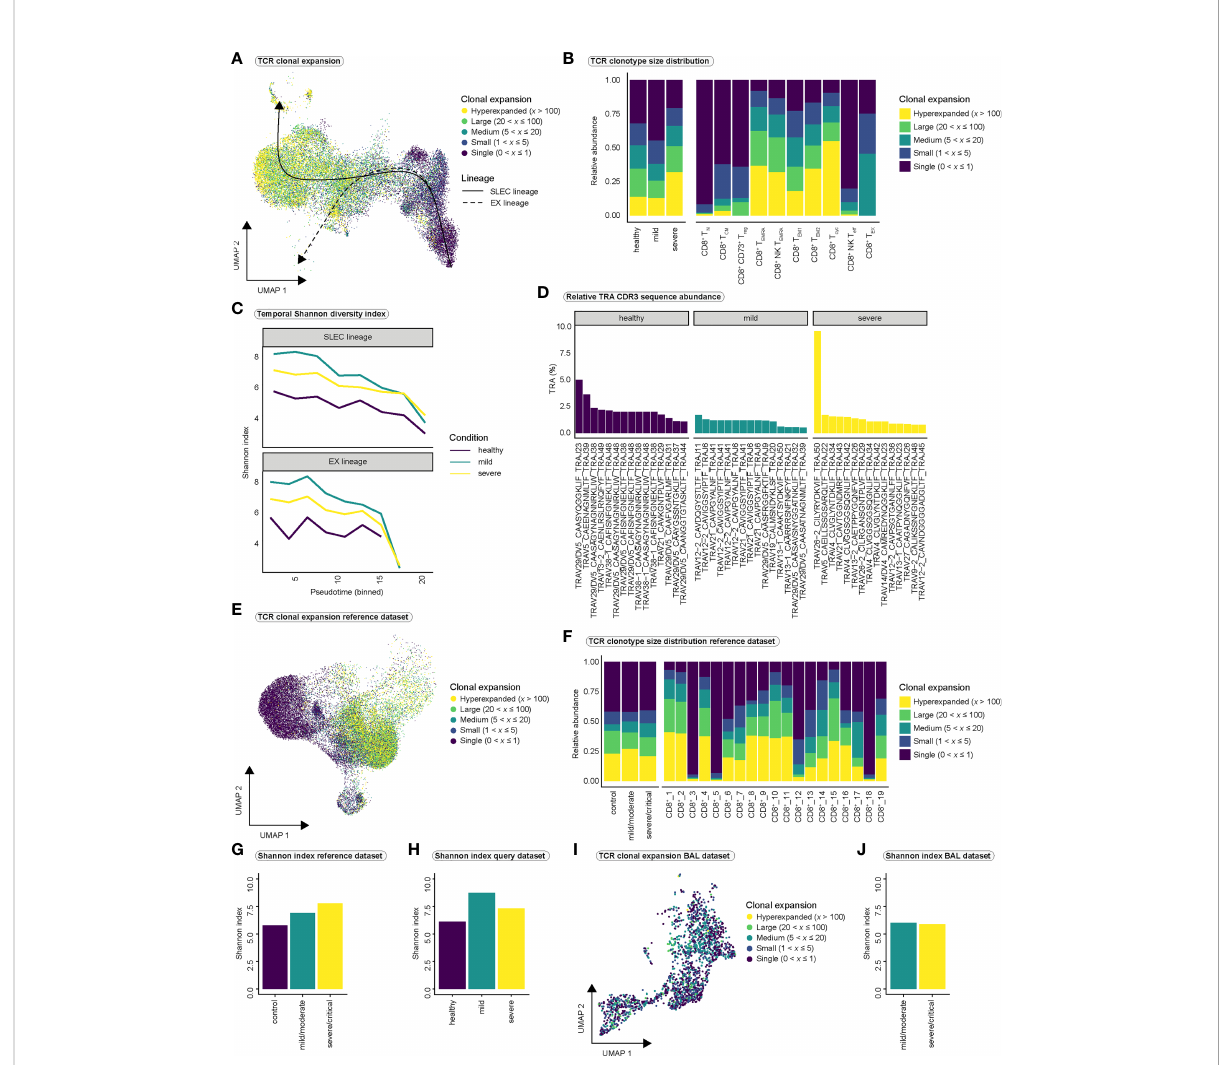
FIGURE 4 Clonal expansion and TCR diversity in COVID-19. (A) T cell receptor clonal expansion projected onto the integrated UMAP of cell types. (B) Distribution of clonal expansion within the conditions (left) and within the CD8 + T cell populations (right), displayed as relative abundance of clonotype expansion groupings (Figure S5A is referred to for abundance per cell type within each condition). (C) Shannon diversity index as a measure of clonal diversity across pseudotime for the three conditions among SLEC and EX lineages. Shannon index was calculated on the whole TCR sequences, including TRA and TRB chains. (D) Relative proportion of CDR3 sequences of the 15 most abundant clones to the total number of CDR3 sequences per condition for the TRA chain (Figure S5C is referred to for the relative proportion of CDR3 sequences for the TRB chain). (E) TCR clonal expansion projected onto the UMAP of the PBMC-derived CD8 + reference dataset. (F) Distribution of clonal expansion within the conditions (left) and within the CD8 + T cell populations (right), displayed as relative abundance of clonotype expansion groupings for the PBMC-derived reference dataset. (Figure S5D is referred to for abundance per cell type within each condition of the reference dataset). (G) Shannon diversity index per condition for the PBMC-derived reference dataset and (H) for our query dataset. (I) TCR clonal expansion projected onto the UMAP of the BAL-derived CD8 + reference dataset. (J) Shannon diversity index per condition for the BAL-derived reference dataset. TCR, T cell receptor; SLEC, short-lived effector cell; EX, exhaustion; TRA, T cell receptor alpha chain; TRB, T cell receptor beta chain; CDR3, Complementarity determining region 3; BAL, bronchoalveolar